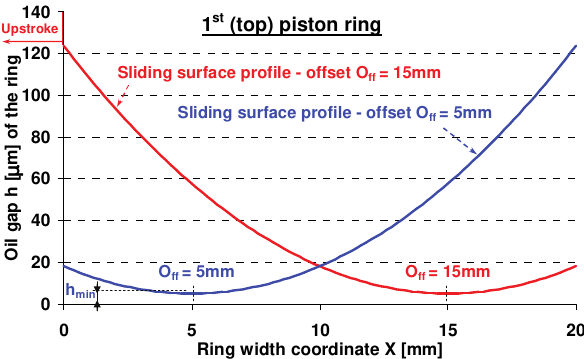
Table 2. Basic geometric parameters of piston rings: 1, 2, 3, 4 Axial height of piston ring H = 20 mm Radius of parabolic sliding surface R = 950 mm Offset of parabolic sliding surface